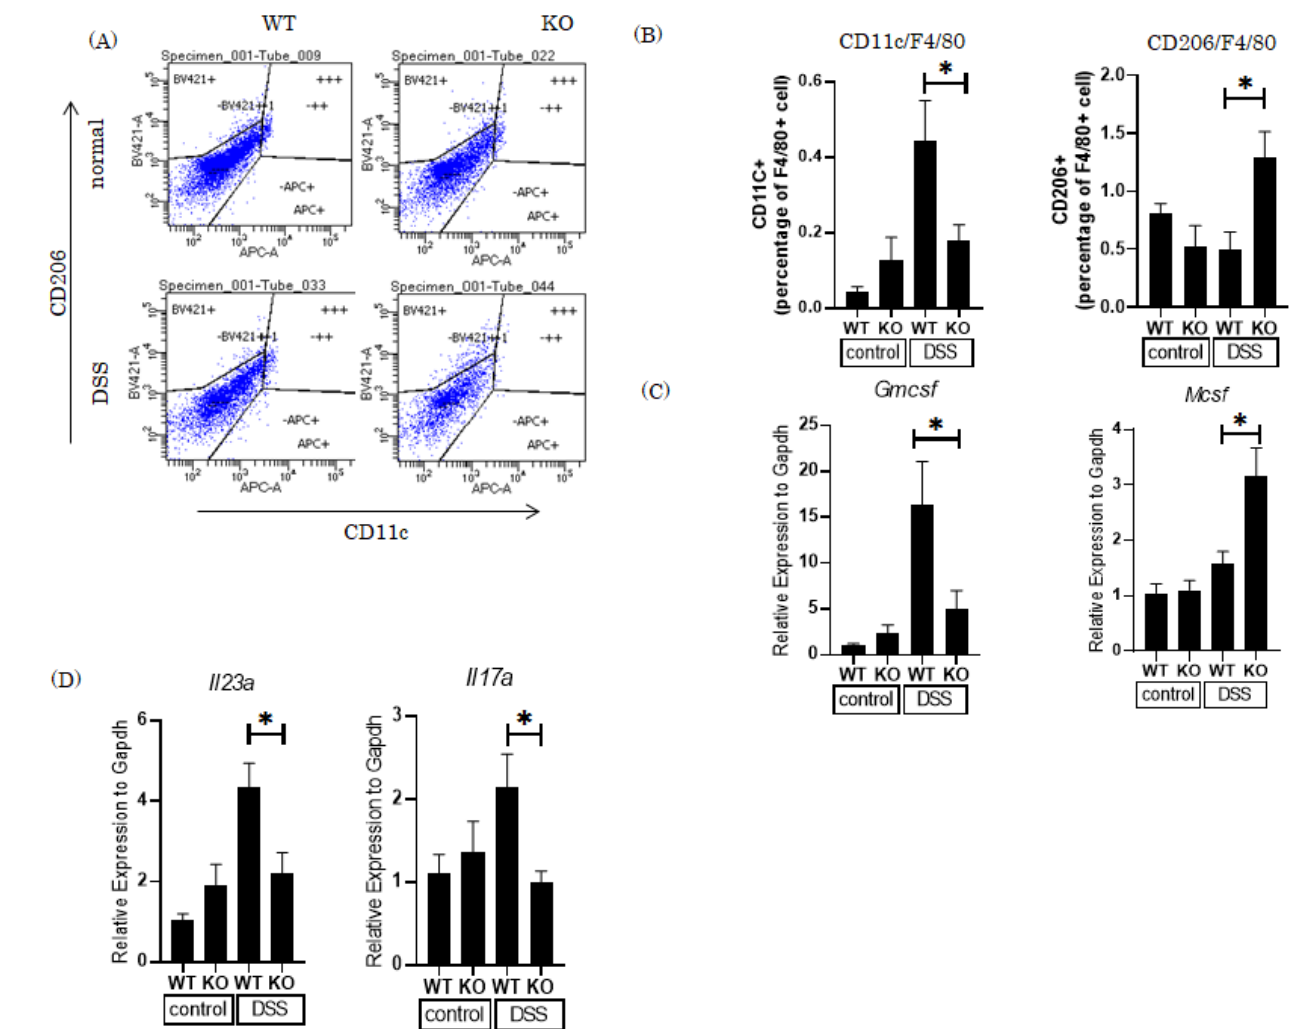
Figure 3. Increased M2 macrophages and suppressed Th17-related cytokines and antimicrobial peptides in the Pin1 KO mouse colon tissues after DSS treatment. Global Pin1 KO mice were generated by mating Pin1 fl/fl and CAG cre-TG mice. (n = 5–8) ( A ) Representative FACS plots show the percentage of M1 and M2 macrophages among total macrophages isolated from the colonic lamina propria of Pin1 KO and control Pin1 fl/fl mice that had been treated with 3% DSS for 7 days. ( B ) The percentages of M1 and M2 macrophages. ( C ) The mRNA expression levels of Gmscf and Mcsf in colonic tissues isolated from Pin1 KO and control Pin1fl/fl mice that had been treated with 3% DSS for 7 days. ( D ) The mRNA expression levels of Il23a and Il17 in colonic tissues isolated from Pin1 KO and control Pin1 fl/fl mice that had been treated with 3% DSS for 7 days. Significant differences were identified by applying a one-way ANOVA followed by Tukey’s multiple comparisons test. * p < 0.05, Values are means ± SEM.